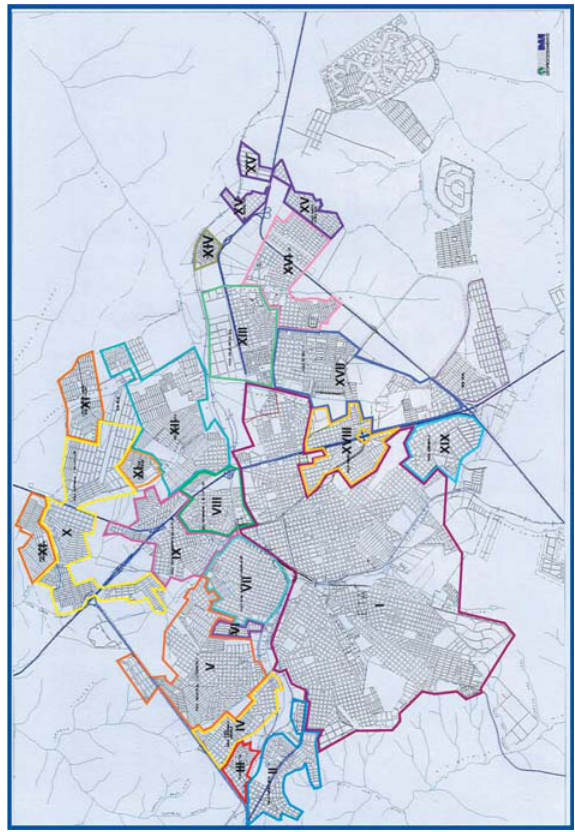
Figure 1- Localization of the 19 sectors of water supply, Bauru 26 ,